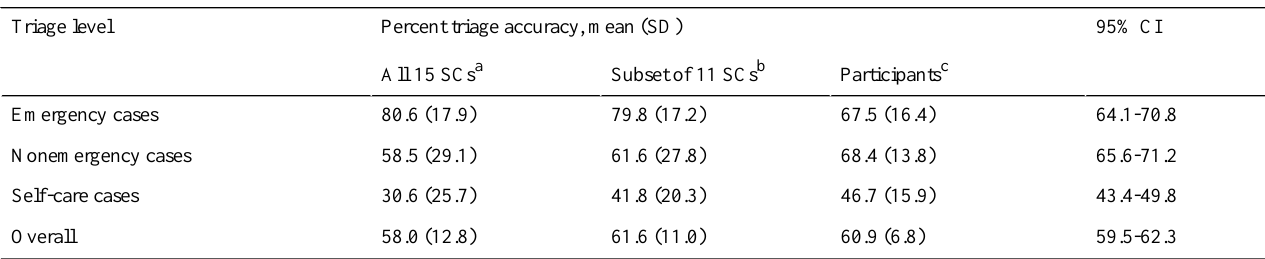
Table 2. Mean triage accuracy of symptom checkers and participants.